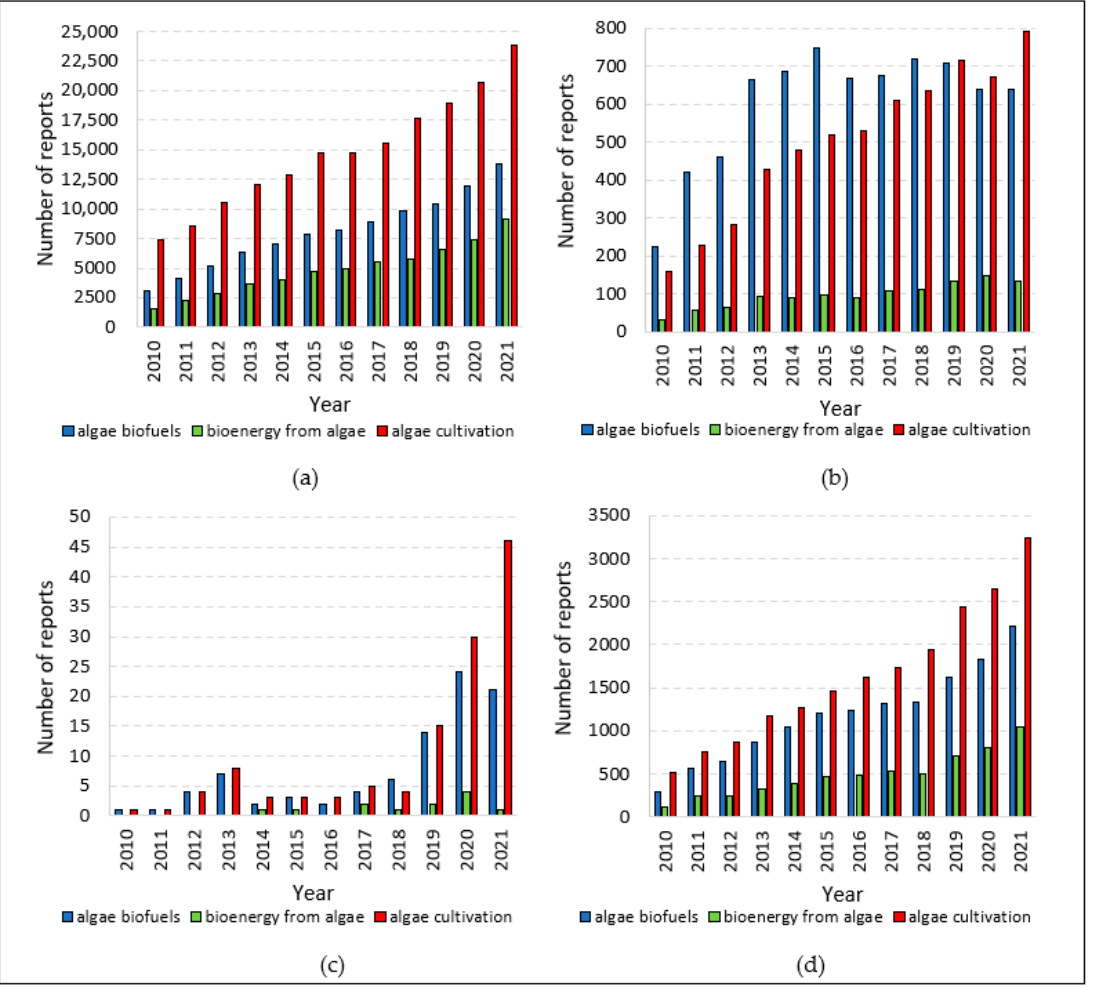
Figure 3. Article results in ( a ) Google Scholar, ( b ) Scopus, ( c ) MDPI and ( d ) Science Direct between 2010 and 2021 for the keywords “algae biofuels”, “bioenergy from algae” and “algae cultivation”. Accessed 24 October 2022.